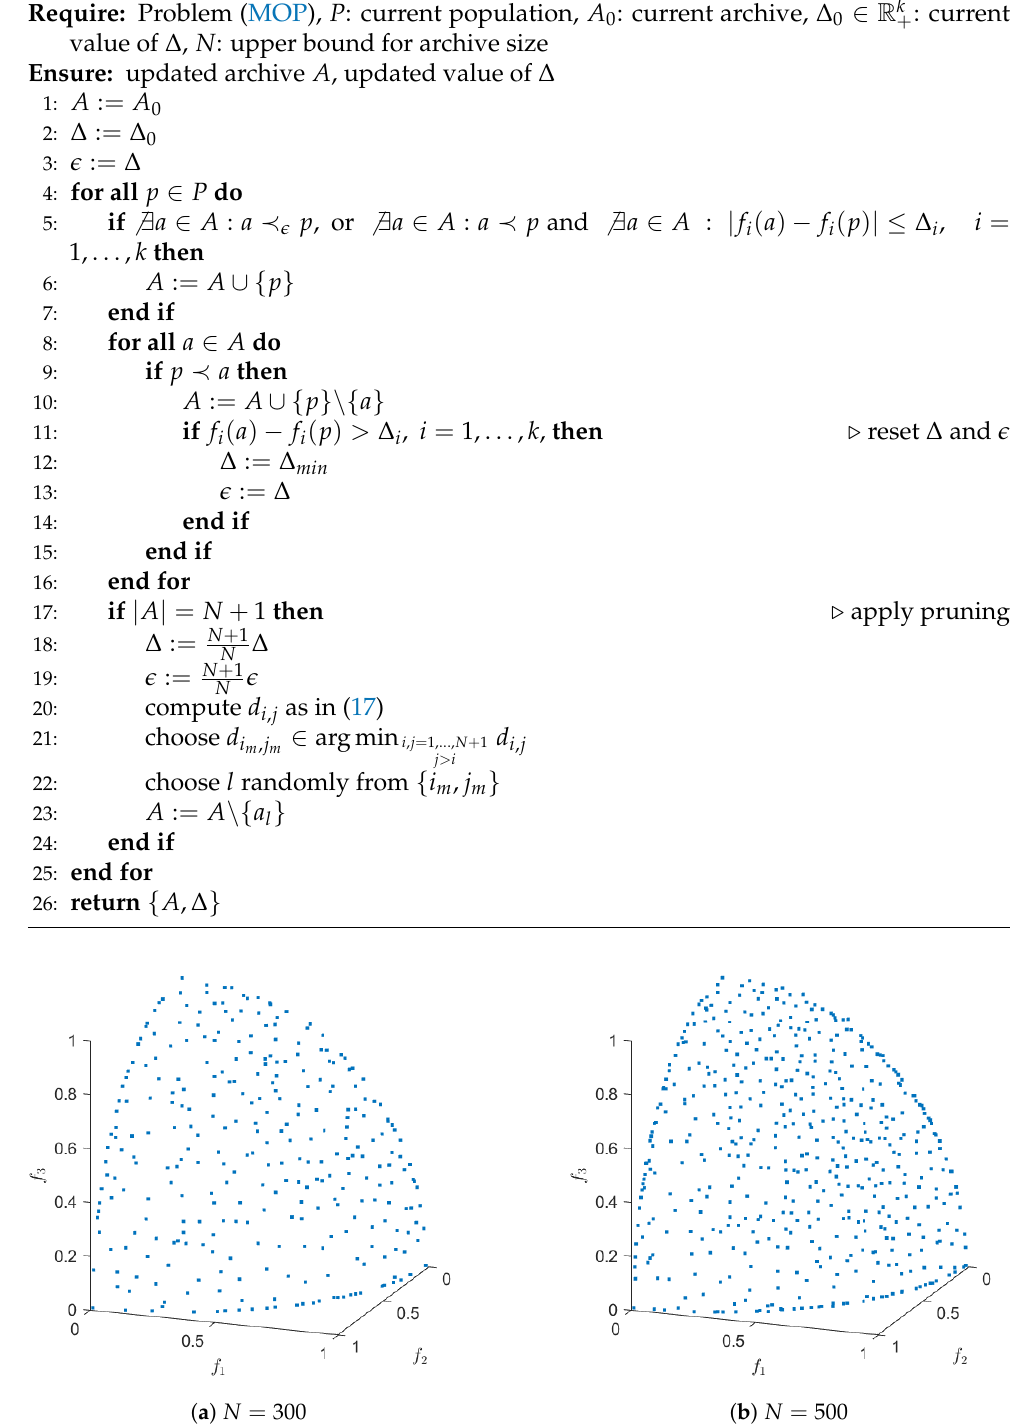
Figure 7. Results of ArchiveUpdateHD on DTLZ2 for different values of N